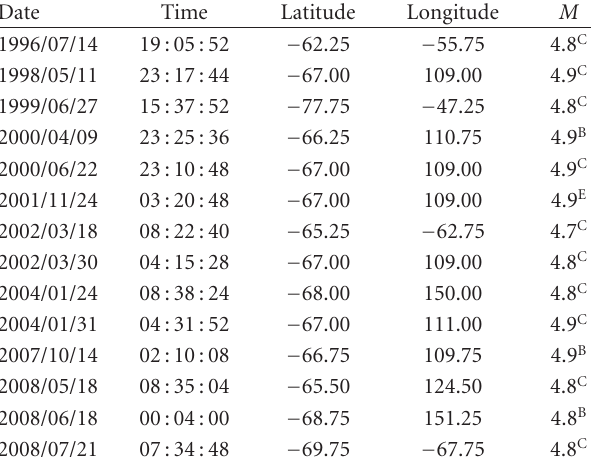
Source parameters for 14 detected plausible glacial earthquakes in Antarctica during 1993–2008 (modified after 2010 [12]). Origin times and epicenters are determined by the surface- wave detection